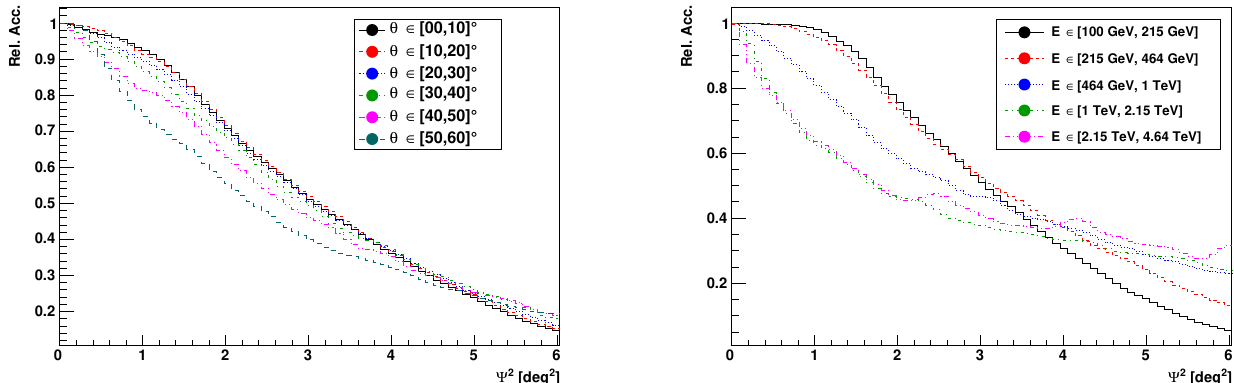
Figure 8. ( Left ) Radial acceptance curves for different zenith angle bands. ( Right ) Radial acceptance curves for different energy